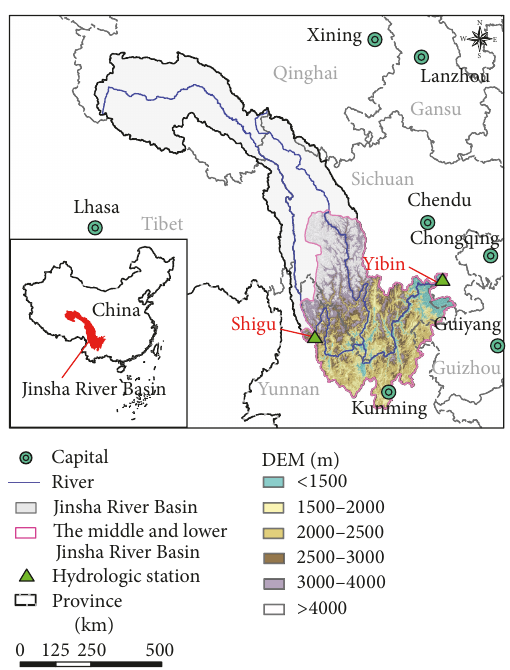
Figure 1: Comprehensive map of the study